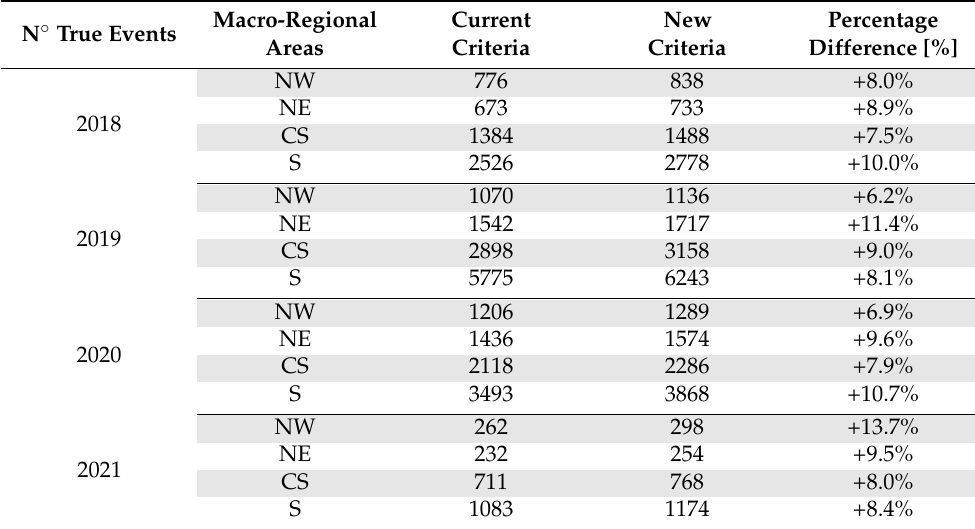
Table 7. Number of true events: criteria comparison at macro-regional area level.